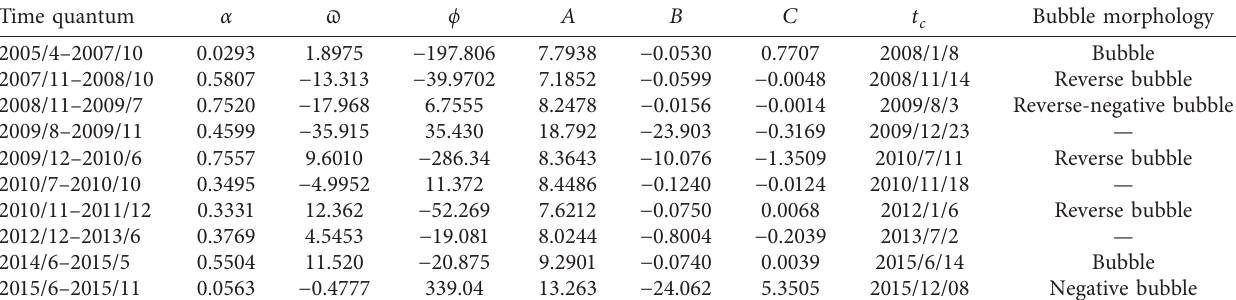
Table 5: LPPL model fitting of the rate of return of CSI 300 index.